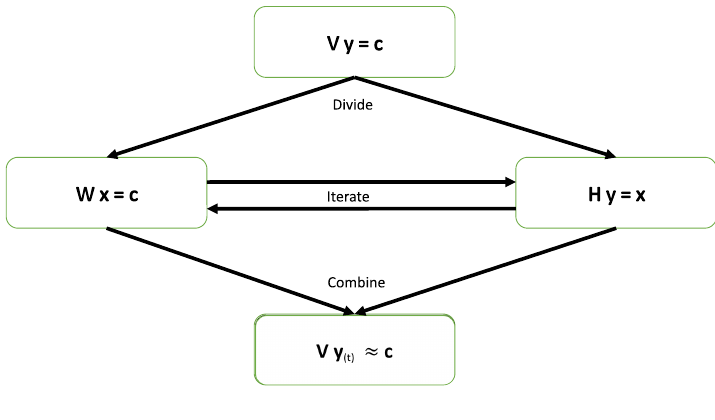
Figure 1. Illustration of the proposed new divide-and-iterate